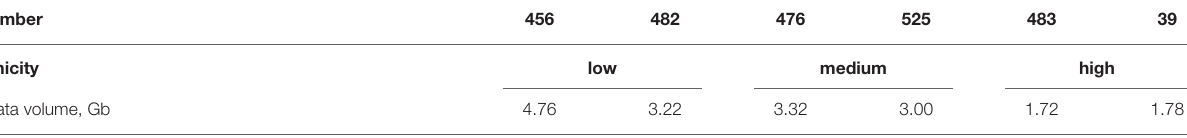
TABLE 2 | Percentages of aligned Illumina reads against the assembly of F. oxysporum f. sp. lini isolate #39 and the complete genomes of F. oxysporum strains Fo47 and Fo5176 and percentages of the genomes covered by Illumina reads for six F. oxysporum f. sp. lini strains. Strain number Pathogenicity low Illumina data volume,